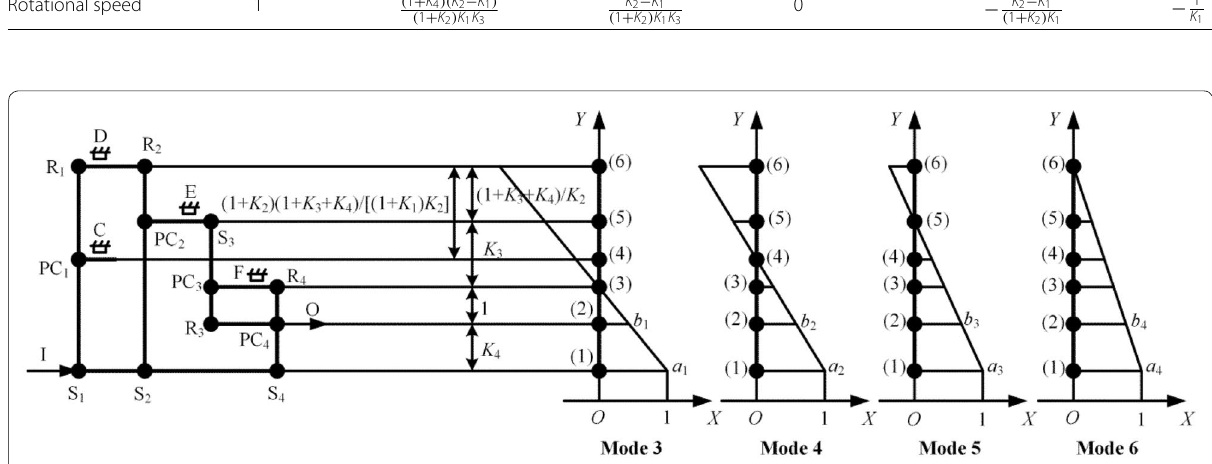
Figure 13 Equivalent lever speed diagram when the clutch A engaged